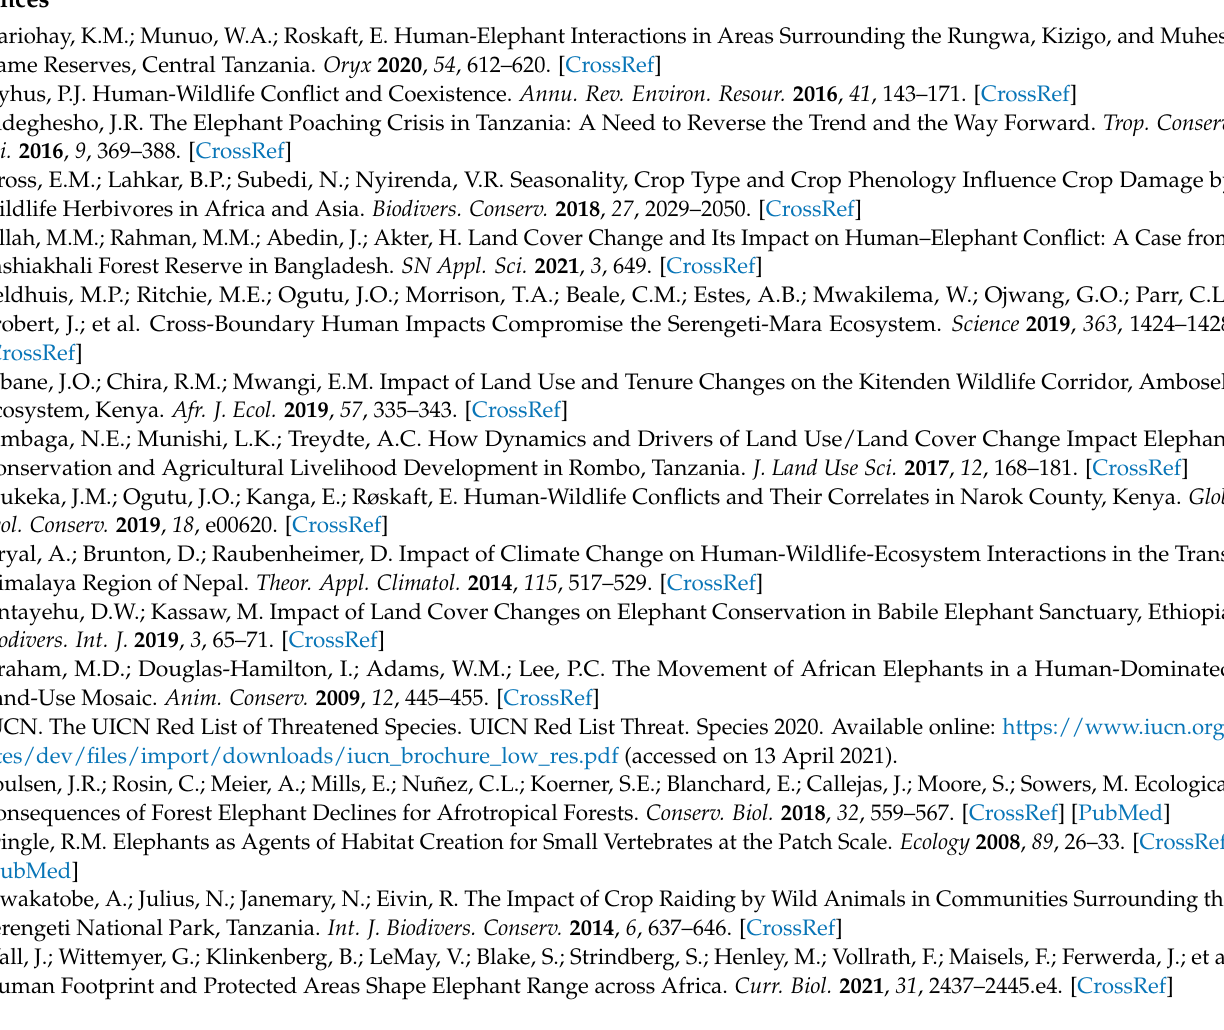
and 2019. (Note: no data were collected in the months Dec and Jan, likely indicating no HEC oc-